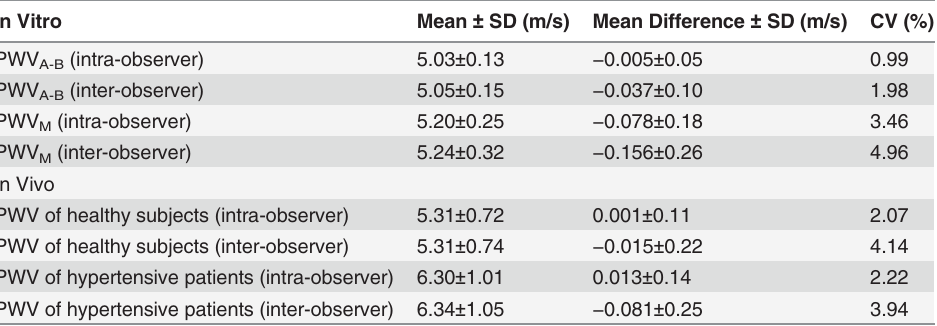
Table 2. The reproducibility of the PWV measurements in vitro and in vivo studies. In Vitro